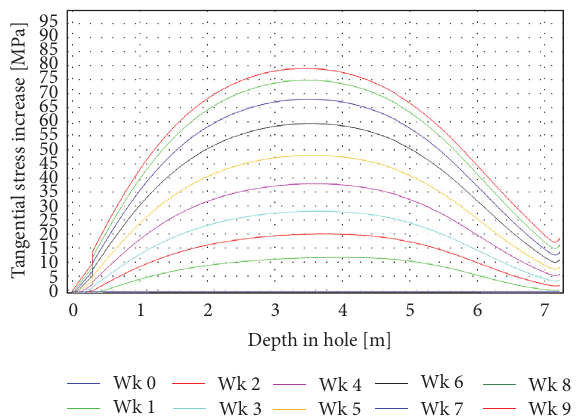
Figure 12: Full model tangential stress increase calculated at the inner surface of the rock mass in the North wall (weeks